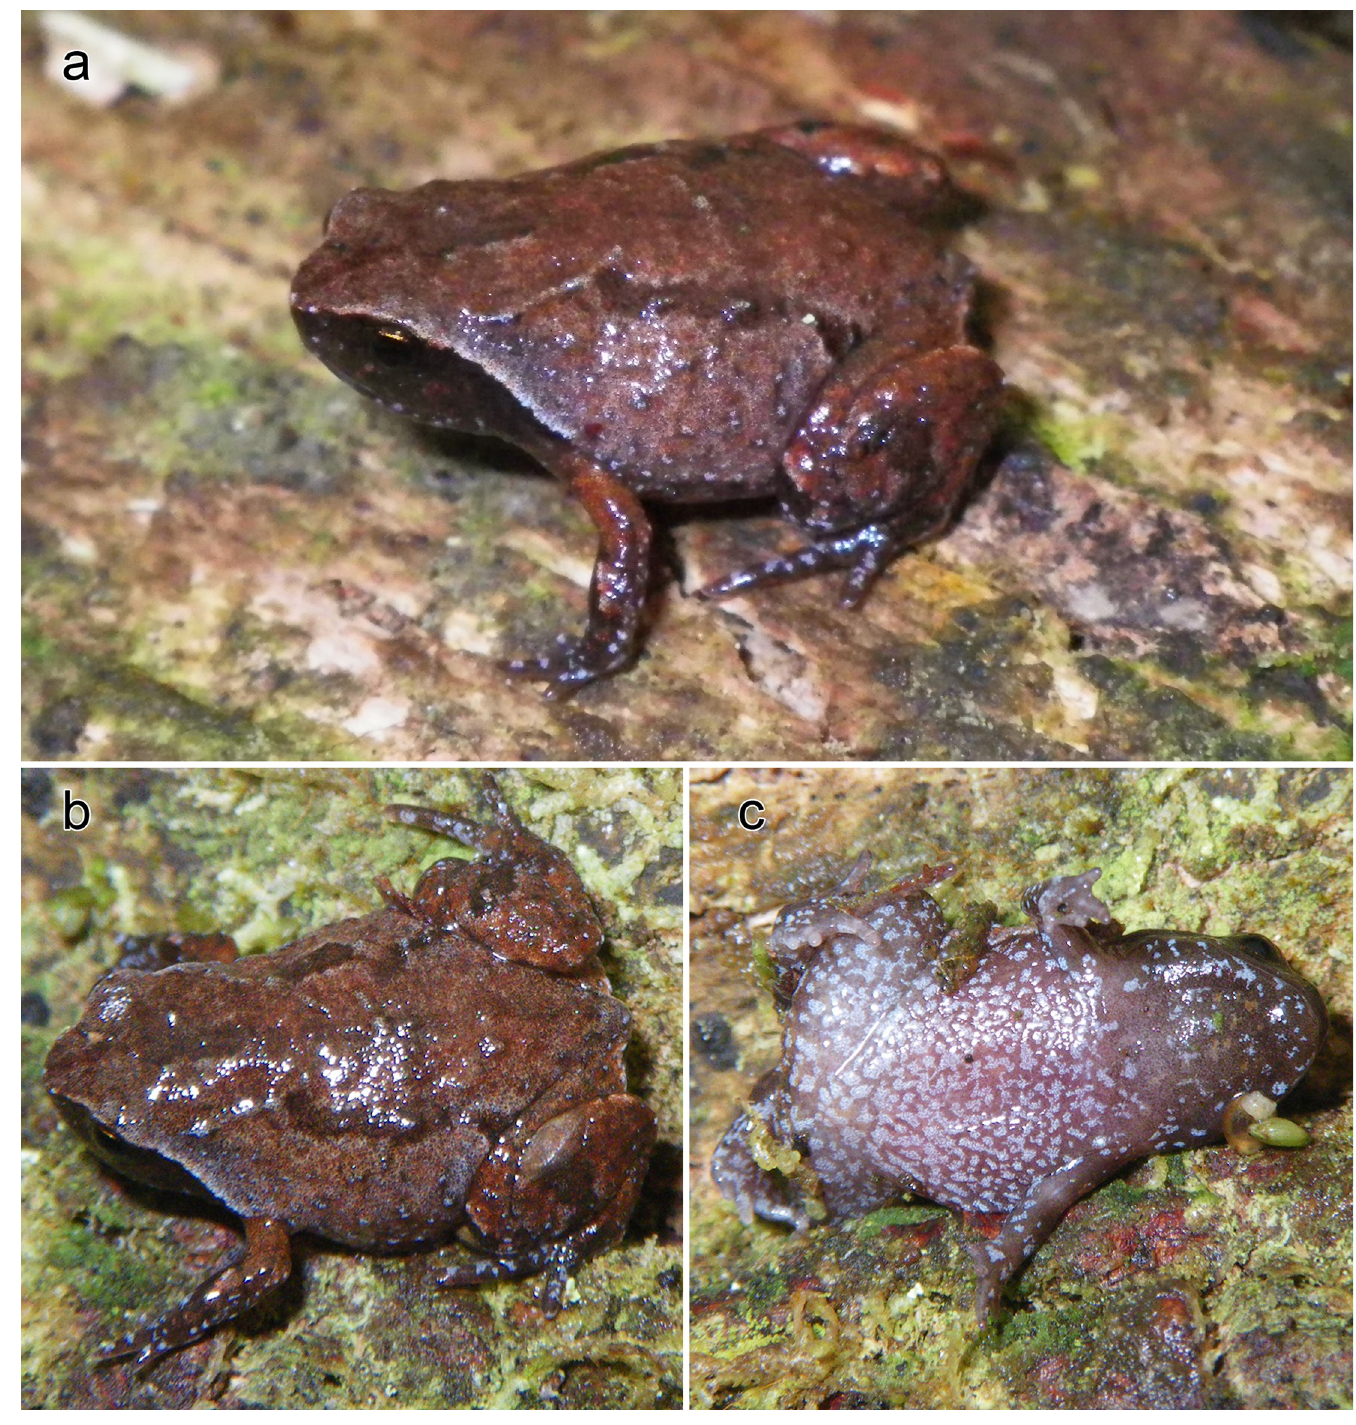
Fig 10. Rhombophryne proportionalis sp. nov., holotype ZSM 1826/2010, in life. (a) dorsolateral, (b) dorsal, and (c) ventral view.